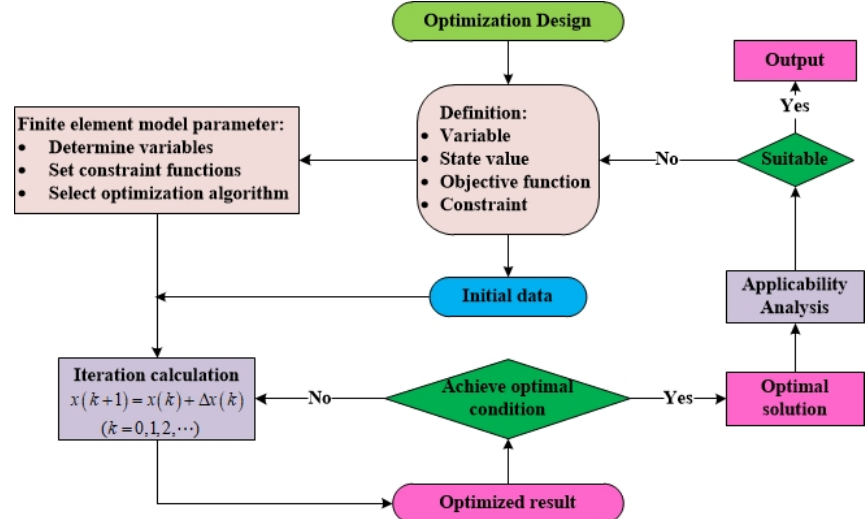
Figure 2. Optimization framework of the asynchronous motor